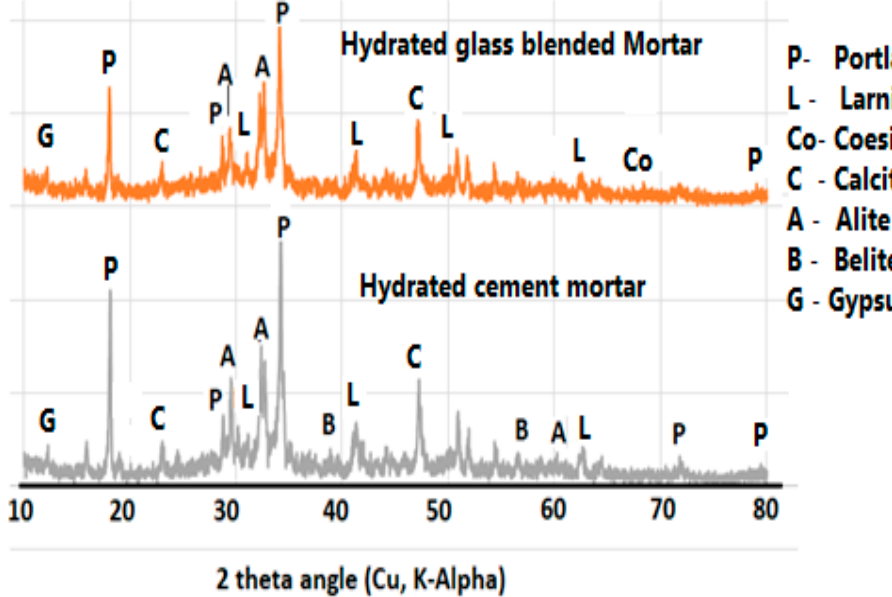
Figure 15. XRD diffractogram of glass blended mortar.